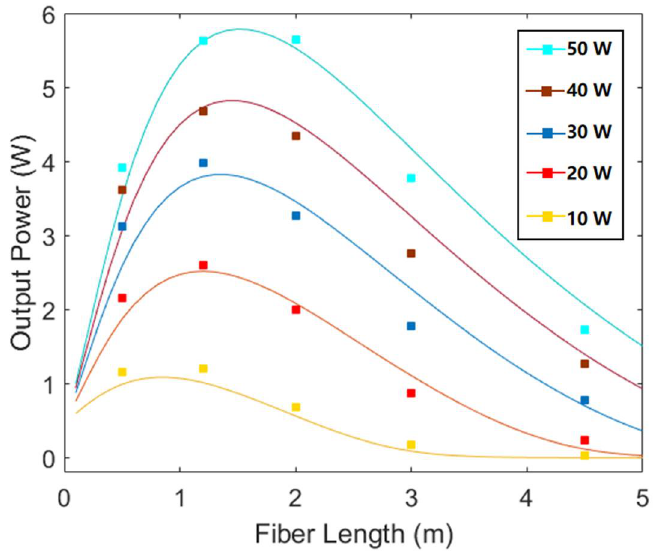
Figure 8. Relationship between amplified signal power and fiber length under different pump power. The solid line is calculated theoretically, and the square point is the experimental data.